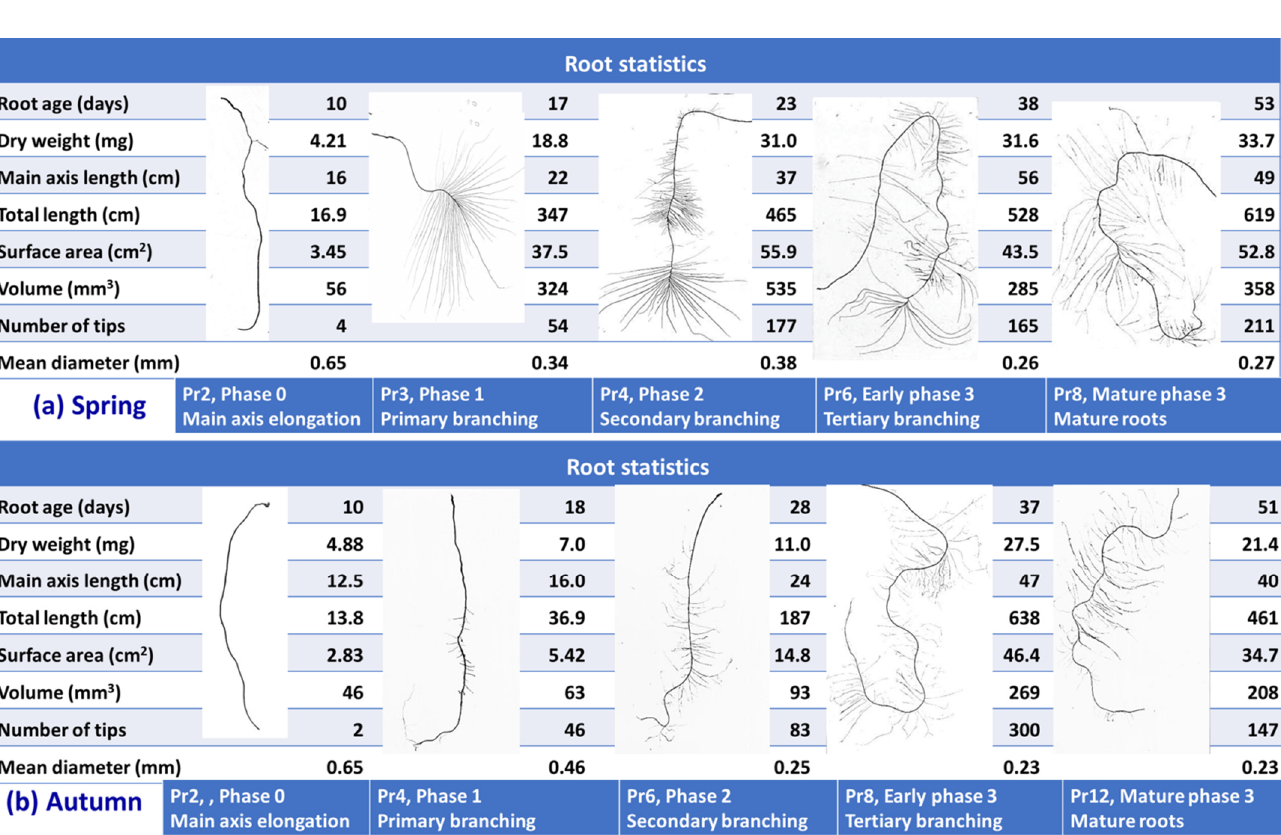
Figure 4. Individual WinRhizo ® scanned roots at different phytomer positions (Pr) along with root statistics showing succession of root development for Aberdart perennial ryegrass in ( a ) spring and ( b ) autumn seasons. Root phases were defined by branching order. Maturity of roots at the late phase 3 was determined by ongoing increase of specific root length without increasing dry matter deposition. Table S3 compares average values of root traits of Pr3-spring vs. Pr4-autumn and Pr8-spring vs. Pr12-autumn with statistical significance.